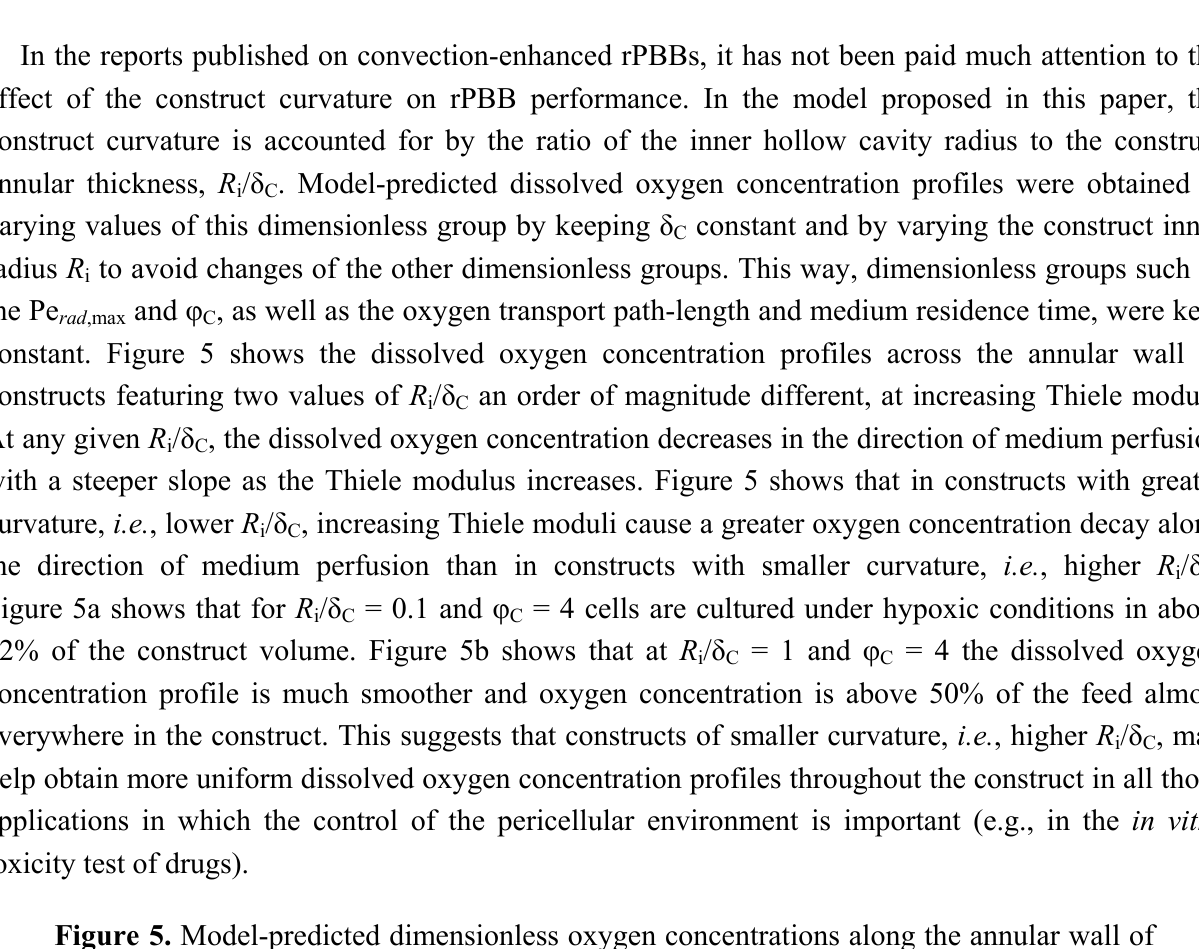
Figure 5. Model-predicted dimensionless oxygen concentrations along the annular wall of constructs, cultured in an rPBB and perfused outwards with medium ( i.e. , γ = 1),